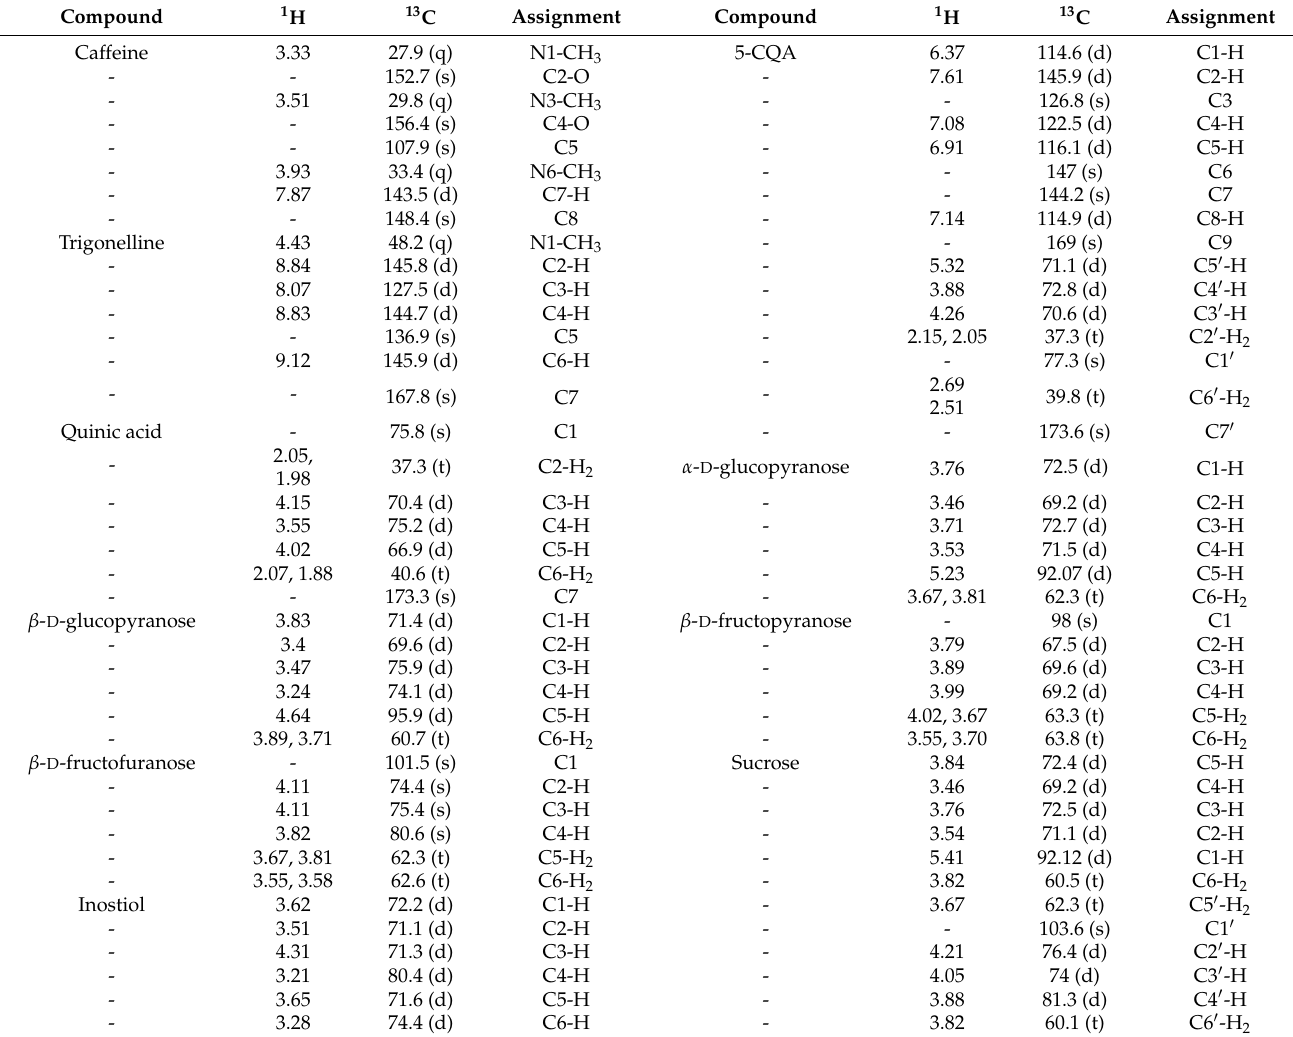
Table 1. The 1D NMR data of CS